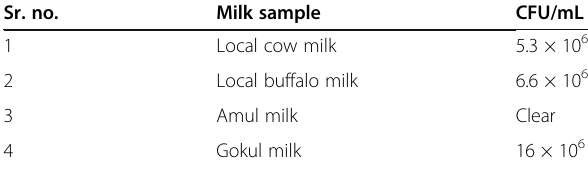
Table 1 Milk sample microbial contaminant CFU/mL count Sr. no.